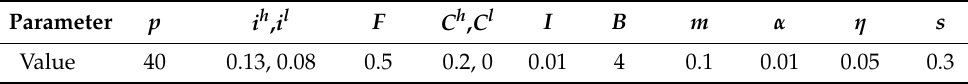
Table 11. Parameter values (when the active online lending platform adopts proper management